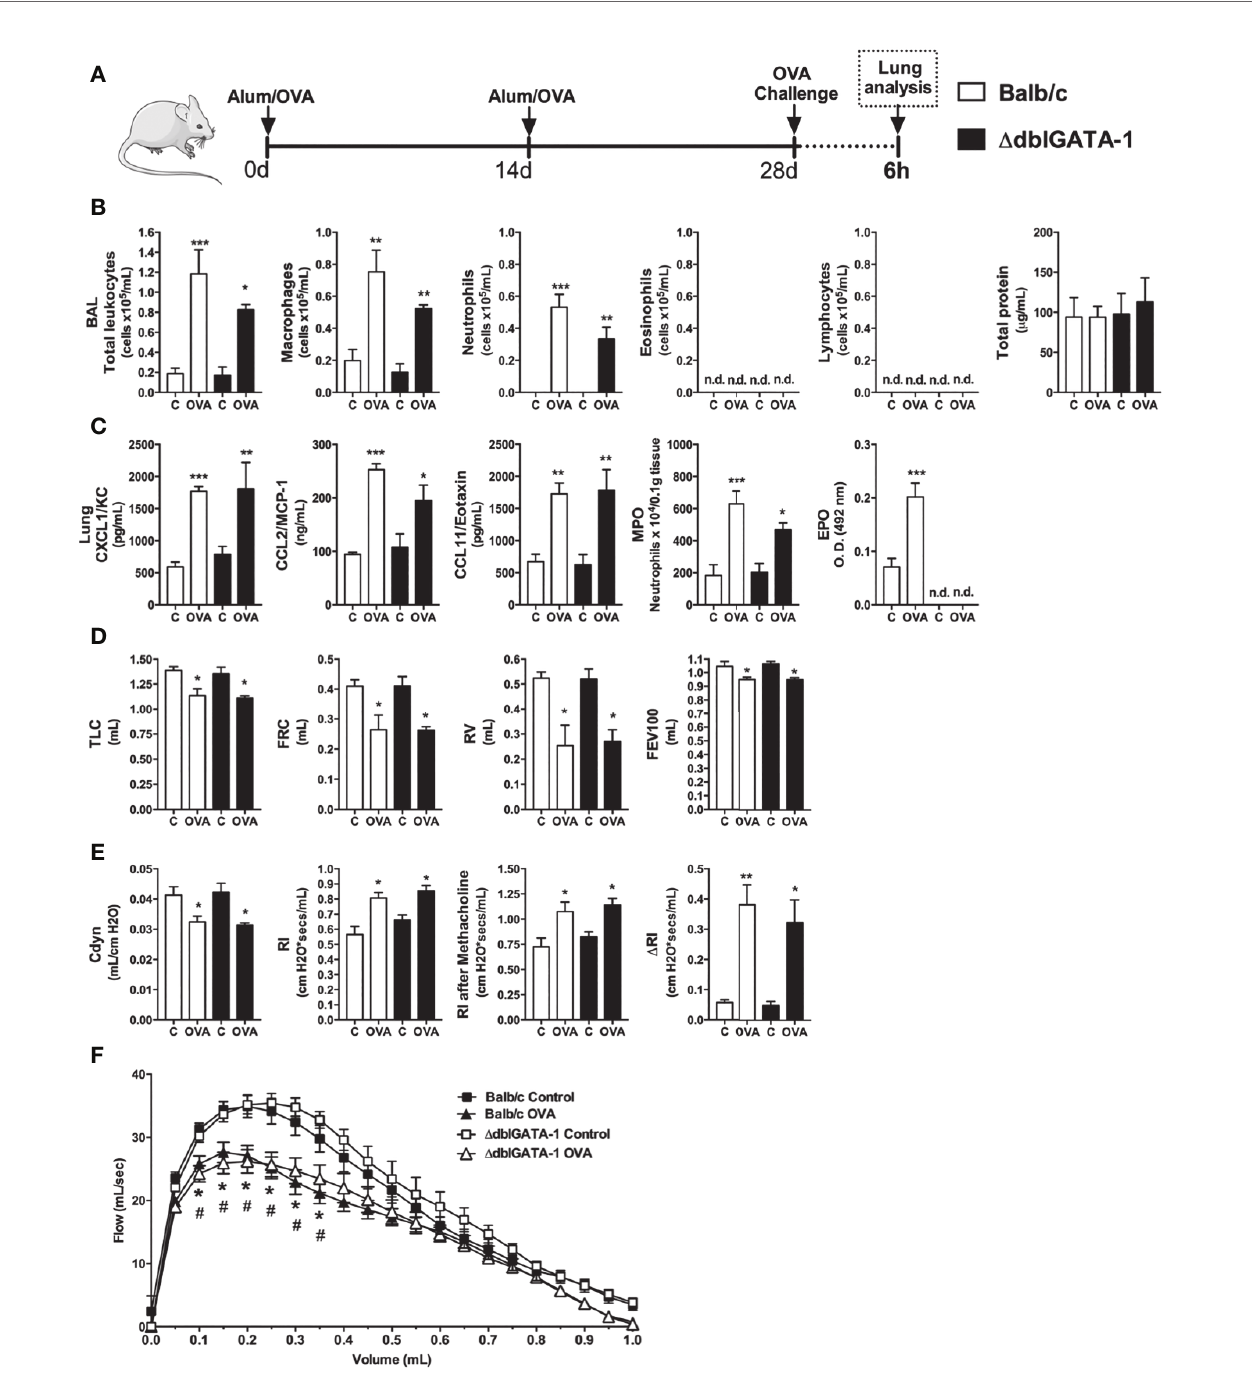
FIGURE 2 | Eosinophils have minor role in the initial moments of Th2 allergy induced by OVA. In fl ammatory parameters were evaluated 6 h after a single challenge with OVA. (A) Schematic representation of the experimental design. (B) Assessment of leukocytes in fl ux and blood leakage into airways. (C) Chemokine levels, MPO and EPO activity assay in lung tissue. Assessment of pulmonary mechanics for (D) lung volumes, (E) compliance and lung resistance. (F) Flow-Volume curve. n = 8 for each group, * for P < 0.05; ** for P < 0.01 and *** for p < 0.001. TLC, total lung capacity; RV, residual volume; FRC, functional residual capacity; FEV100, forced expiratory volume in 100ms; Cdyn: Dynamic compliance; Rl: lung resistance; D Rl, methacholine-evoked hyperresponsiveness. * differences between BALB/c control vs OVA. # differences between dblGATA1 control vs dblGATA1